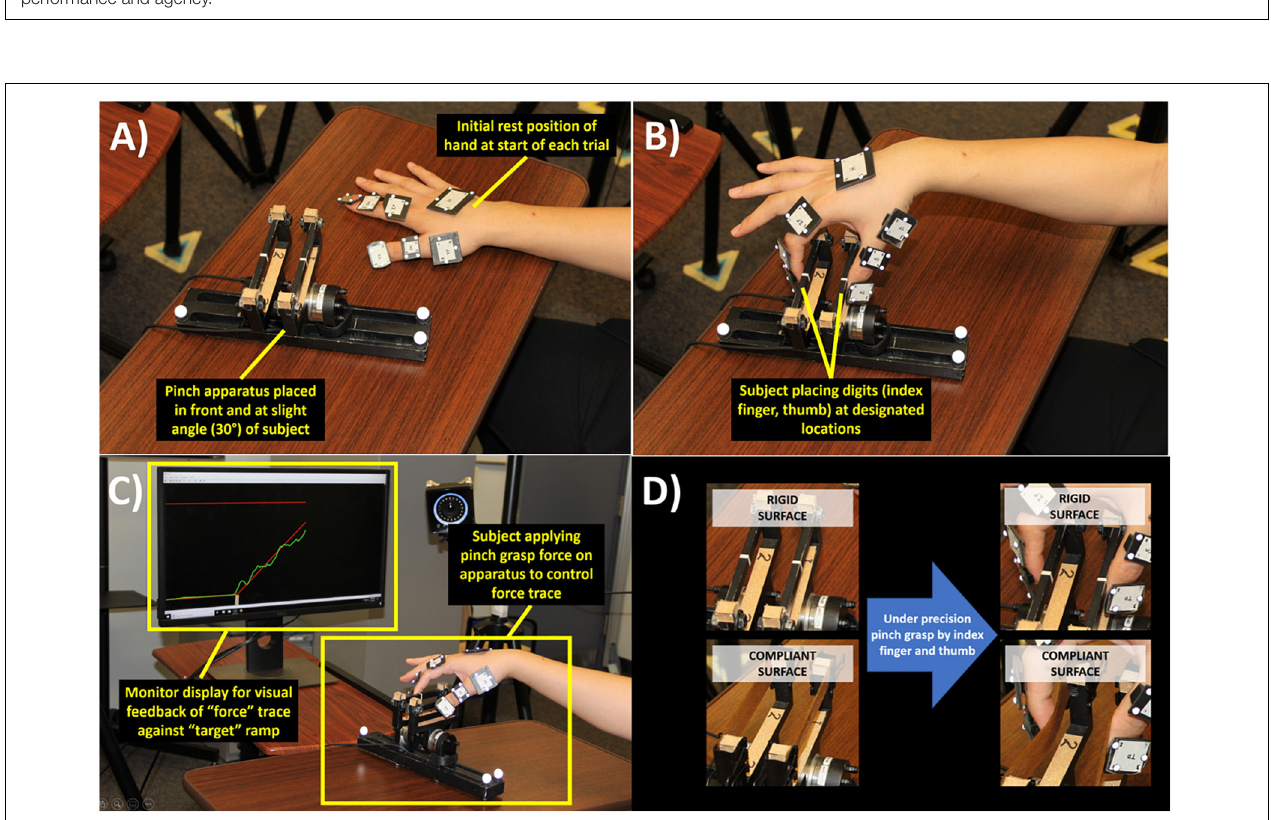
FIGURE 2 | Participant applied grasp force to pinch apparatus each trial. (A) Participant hand initially palm-down on table to start each trial. (B) After trial began, participant moved hand to contact index finger and thumb on designated locations of grasp surfaces on pinch apparatus. (C) Participant progressively applied grasp force to control height (up-down) of force trace to match ramp as trial progressed. (D) Protocol repeated for rigid and compliant grasp surfaces.